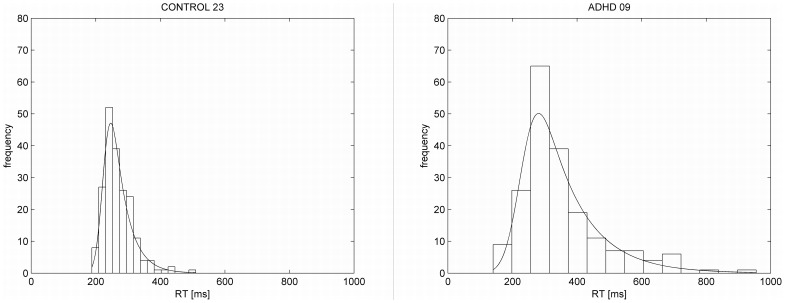
Frequency of intraindividual RTs with fitted ex-Gaussian probability functions exemplary for a control (left) and an ADHD (right) subject.NOTE: Please keep in mind that RTs in ADHD encompass a broader range (200<RT<1000 ms) compared with controls (200<RT<500 ms) resulting in broader frequency bins for the ADHD subject. Both subjects are comparable with regard to relevant demographic variables.